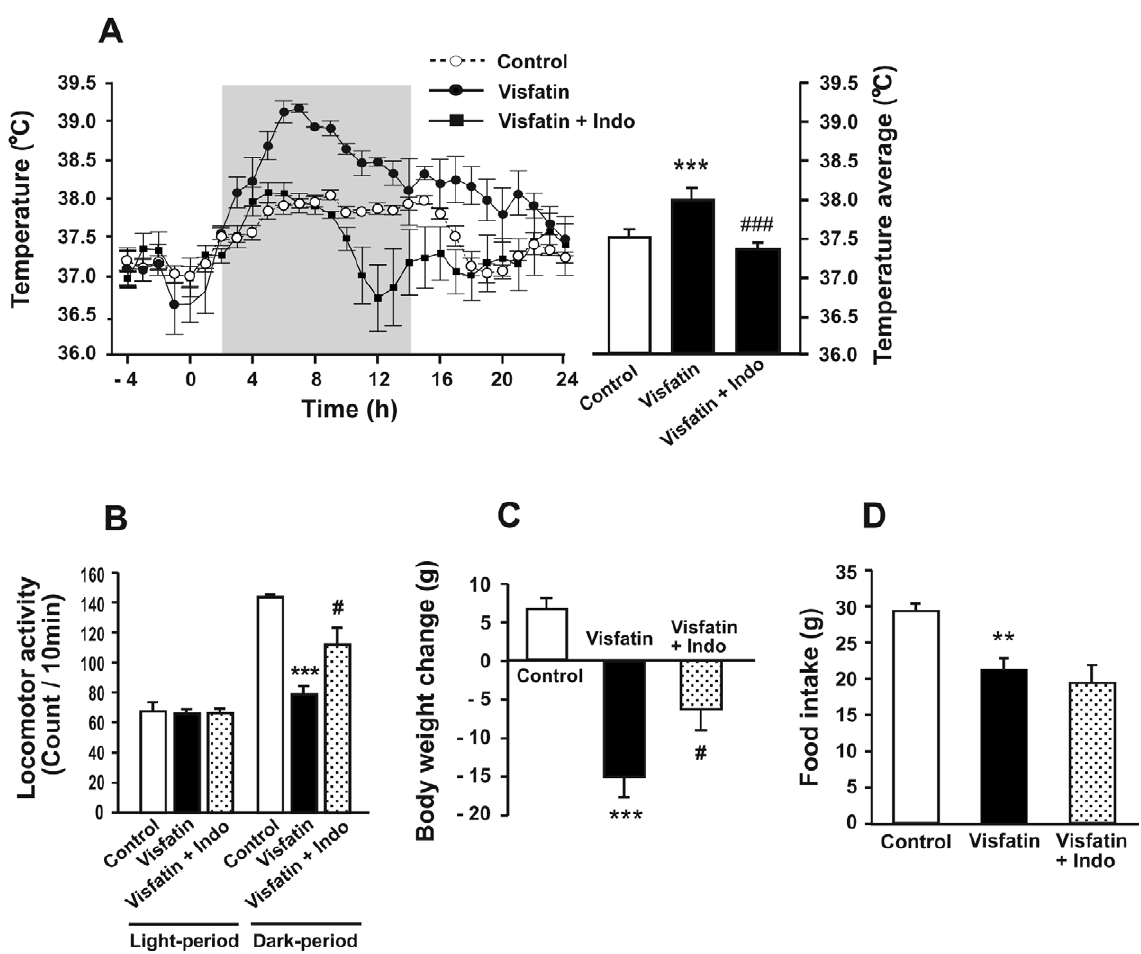
Figure 4. Effect of COX inhibitor on visfatin-induced sickness behaviors. To determine the involvement of prostaglandins on visfatin- induced sickness behaviors, rats were IP-injected with indomethacin (Indo) 30 min prior to injection with visfatin. Parameters such as body temperature, locomotor activity and food intake were observed for one day after injection of visfatin. Indomethacin completely blocked the visfatin- induced increase in body temperature (A) and partially attenuated the effects of visfatin on locomotor activity (B) and body weight (C). However, indomethacin did not affect the visfatin-induced decrease in food intake (D). Data are represented as mean 6 SEM (n=6). **P , 0.01 and ***P , 0.001 vs. control rats injected with 0.9% saline solution; # P , 0.05 and ### P , 0.001 vs. visfatin-injected rats.